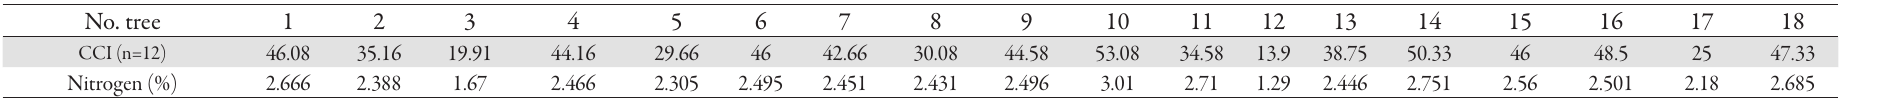
Tab. 2. Nitrogen content and CCM readings in leaf of the Asian pear trees No.